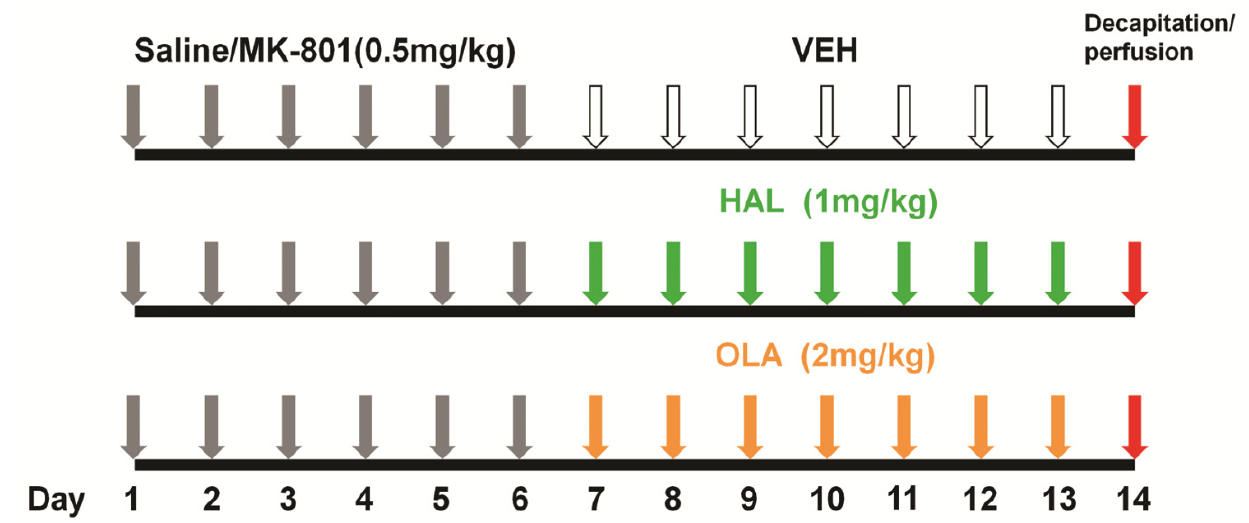
Figure 5. Time schedule of the experimental design.